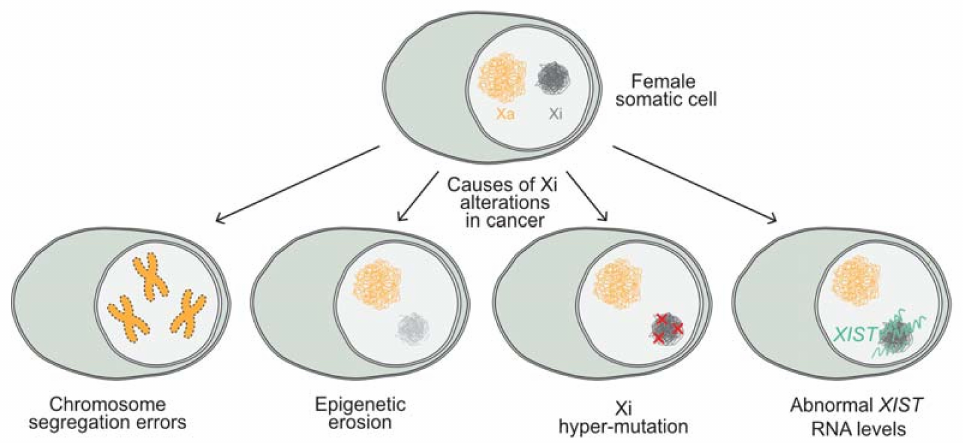
Figure 1. Possible causes of alteration of the Xi in cancer. Female somatic cells have one active and one inactive X chromosome, alterations of the Xi, often observed in cancer. These alterations can be caused by chromosome segregation errors, often leading to loss of the Xi and duplication of the Xa. Epigenetic erosion can lead to reactivation of X-linked genes. Mutations in the Xi happen more often than in other chromosomes. Abnormal Xist RNA levels are also observed in cancer. Xa = Active X chromosome, Xi = Inactive X